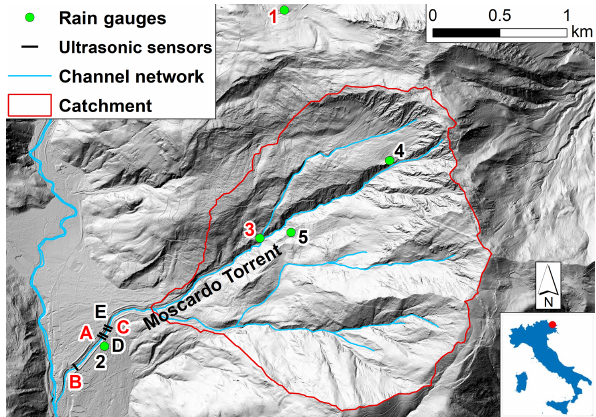
Figure 1. The Moscardo Torrent basin drawn on the digital ter- rain model of Regione Autonoma Friuli Venezia Giulia (https: //irdat.regione.fvg.it/CTRN/ricerca-cartografia/, last access: 5 Jan- uary 2021). The letters and numbers in red refer to monitoring sites that are no longer